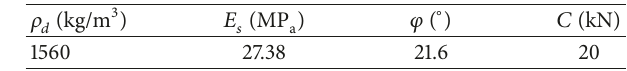
Figure 3: Strain pressure sensor. Table 2: Parameters of dense